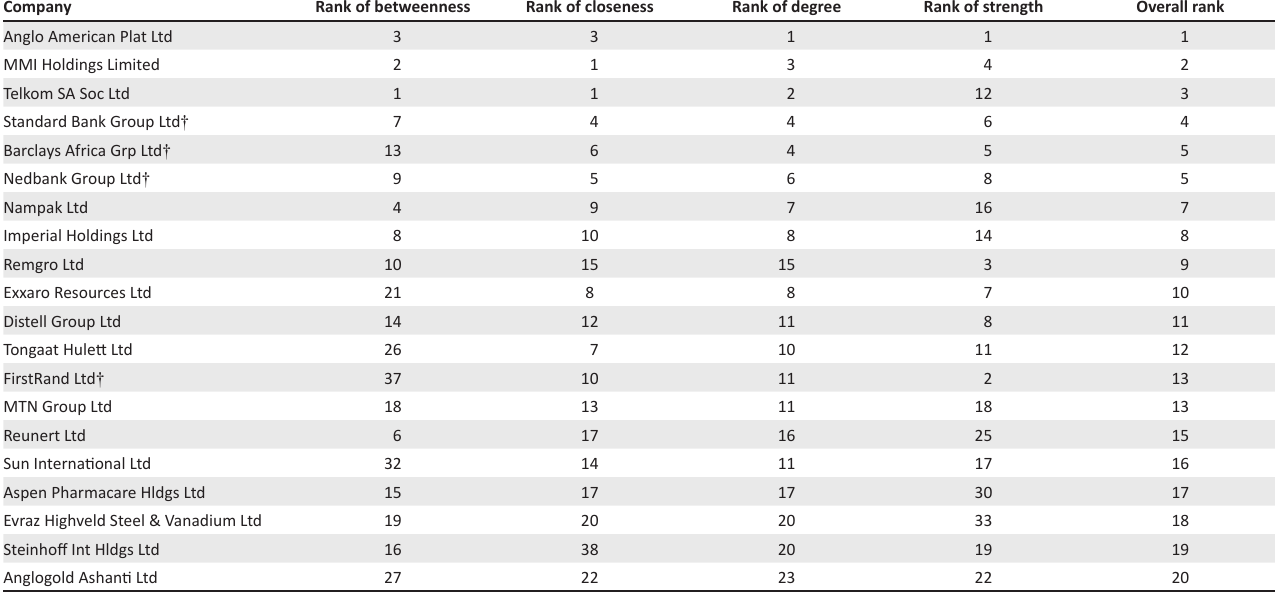
TABLE 2: Summary of rankings.